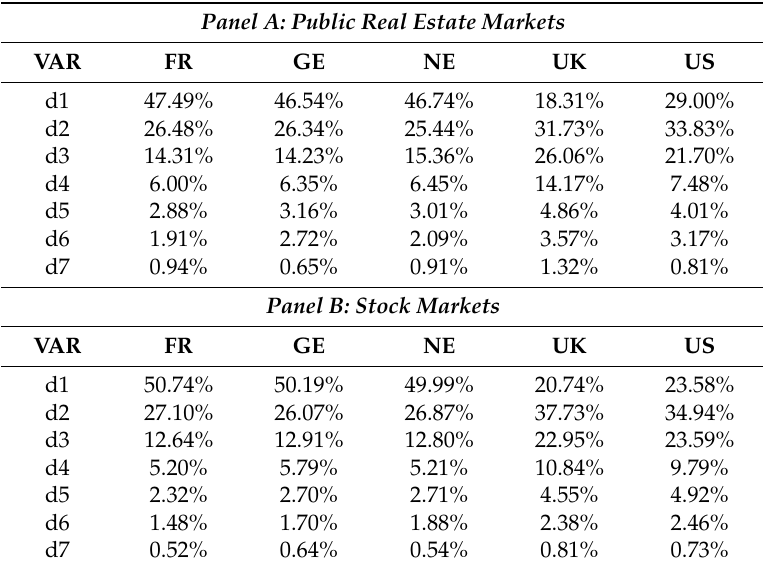
Table 3. Wavelet variance decomposition by time